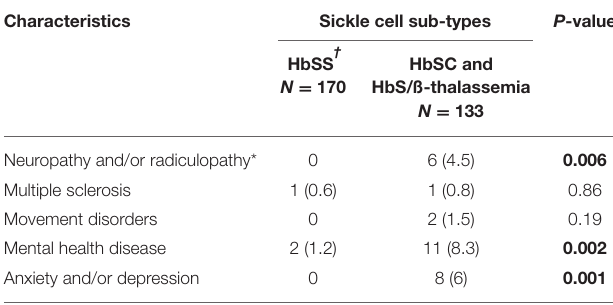
TABLE 5 | Neurological comorbidities in the sickle